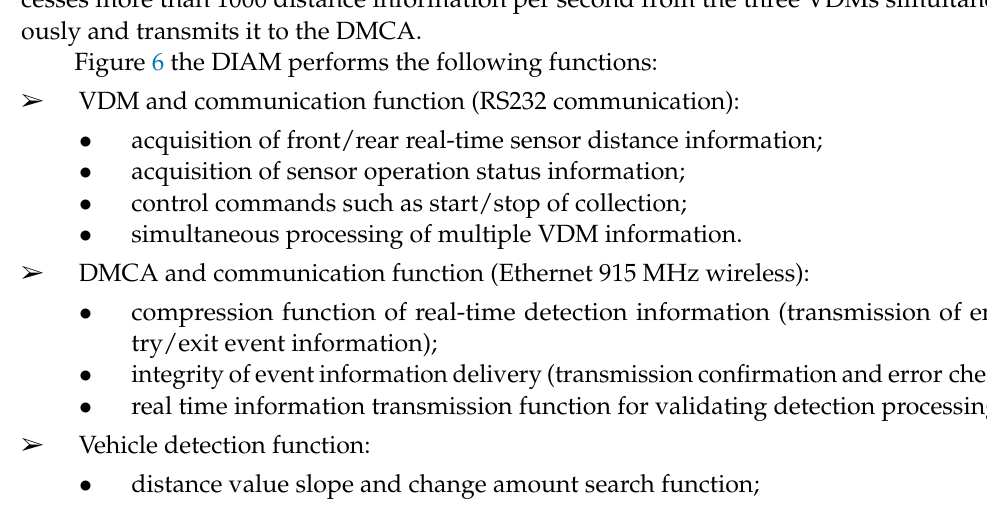
Figure 6 the DIAM performs the following